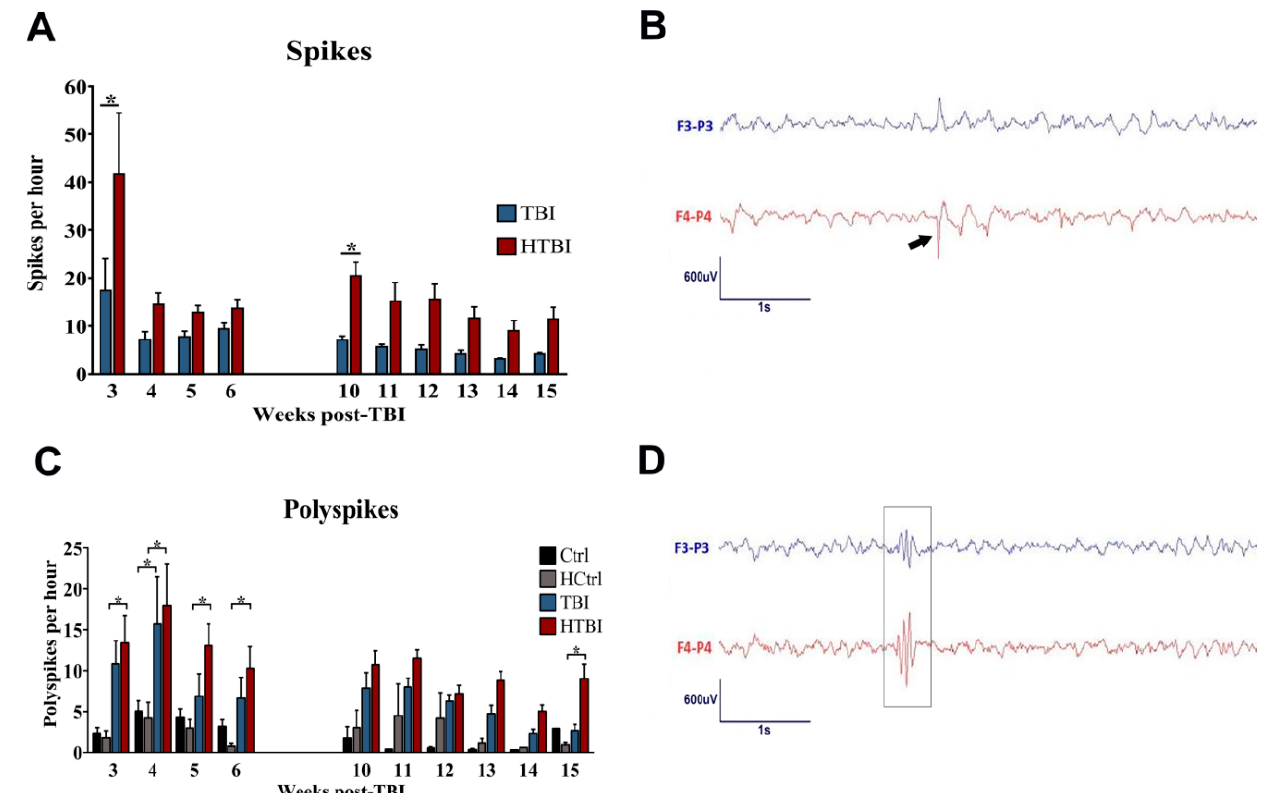
Figure 3. Analyses of the continuous long-term electroencephalogram (EEG) tracings. Spikes and polyspikes were quantified in randomly sampled two-hour epochs per day, one hour from the daytime and one hour from the nighttime. The EEG tracing was interrupted between the 6th and 10th week post-injury to perform behavioral studies: ( A ) spikes were detected in both injured groups, with a higher frequency of spikes in the HTBI group compared to the TBI group, with statistical significance at 3 and 10 weeks post-TBI ( p < 0.05), as revealed by two-way ANOVA with post hoc Fisher’s least significant difference (LSD). The frequency of spikes dropped in the 4th week post-TBI and plateaued thereafter. No spikes were detected in control rats; ( B ) shown is the EEG tracing of one rat with four sampling electrodes (F3: left frontal, F4: right frontal, P3: left parietal, P4: right parietal), in the longitudinal bipolar montage. The arrow points to a spike morphologically characterized by a pointed peak, followed by a repolarization wave. The spike has a higher amplitude over, and therefore localizes to, the right hemisphere, which is the side of the traumatic impact; ( C ) polyspikes were detected in all groups. The HTBI group had a significantly higher polyspike frequency, compared to its control, the HCtrl group, in the first month of EEG recording, as well as in the EEG tracing obtained in the last week of the study ( p < 0.05, two-way ANOVA with post hoc Fisher’s LSD test). The polyspike frequency in the TBI group was statistically comparable ( p > 0.05) to its control (Ctrl) except in the tracing obtained in the 4th week of the recording ( p < 0.05, two-way ANOVA with Fisher’s LSD test). The frequency of polyspikes peaked in the 4th week post-injury (15.7 ± 5.7 spikes/h for TBI, and 18 ± 5.1 spikes/hr for HTBI), following which it plateaued after the 6th week of recording in the HTBI group but continued to drop gradually in the TBI group; ( D ) shown is the EEG tracing of one rat with four sampling electrodes (F3: left frontal, F4: right frontal, P3: left parietal, P4: right parietal), in the longitudinal bipolar montage. The arrow points to a polyspike. Polyspikes consist of two or more spike components. Asterisks indicate statistically significant differences ( p < 0.05). Mean ± SEM are represented. (Ctrl: control, n = 5; HCtrl: heparinized control, n = 5; TBI: traumatic brain injury post-saline, n = 9; HTBI: traumatic brain injury post-heparin, n = 11).